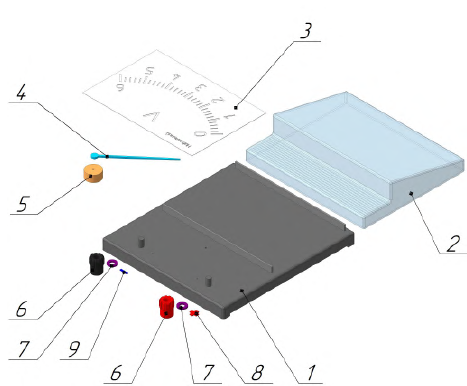
Figure 4: Electronic model of